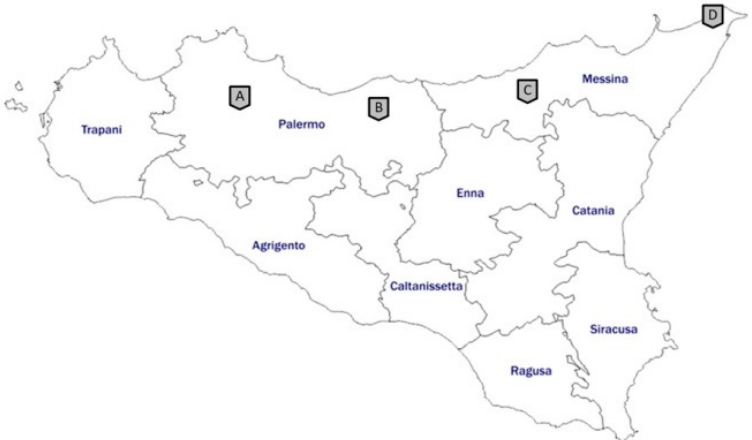
Figure 1. Map of Sicily showing where the animals were obtained. Site A: Wildlife Rescue Center of Bosco di Ficuzza; site B: Parco delle Madonie; site C: Parco dei Nebrodi; site D: Wildlife Rescue Center “Stretto di Messina”.